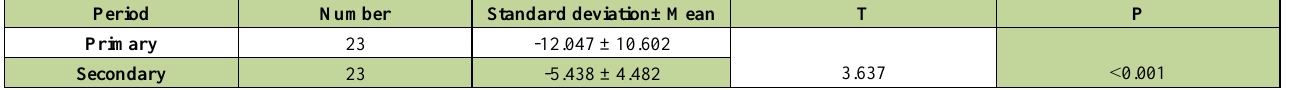
Table 12. Comparison of the mean difference of index plaque in the first and second period in group II.